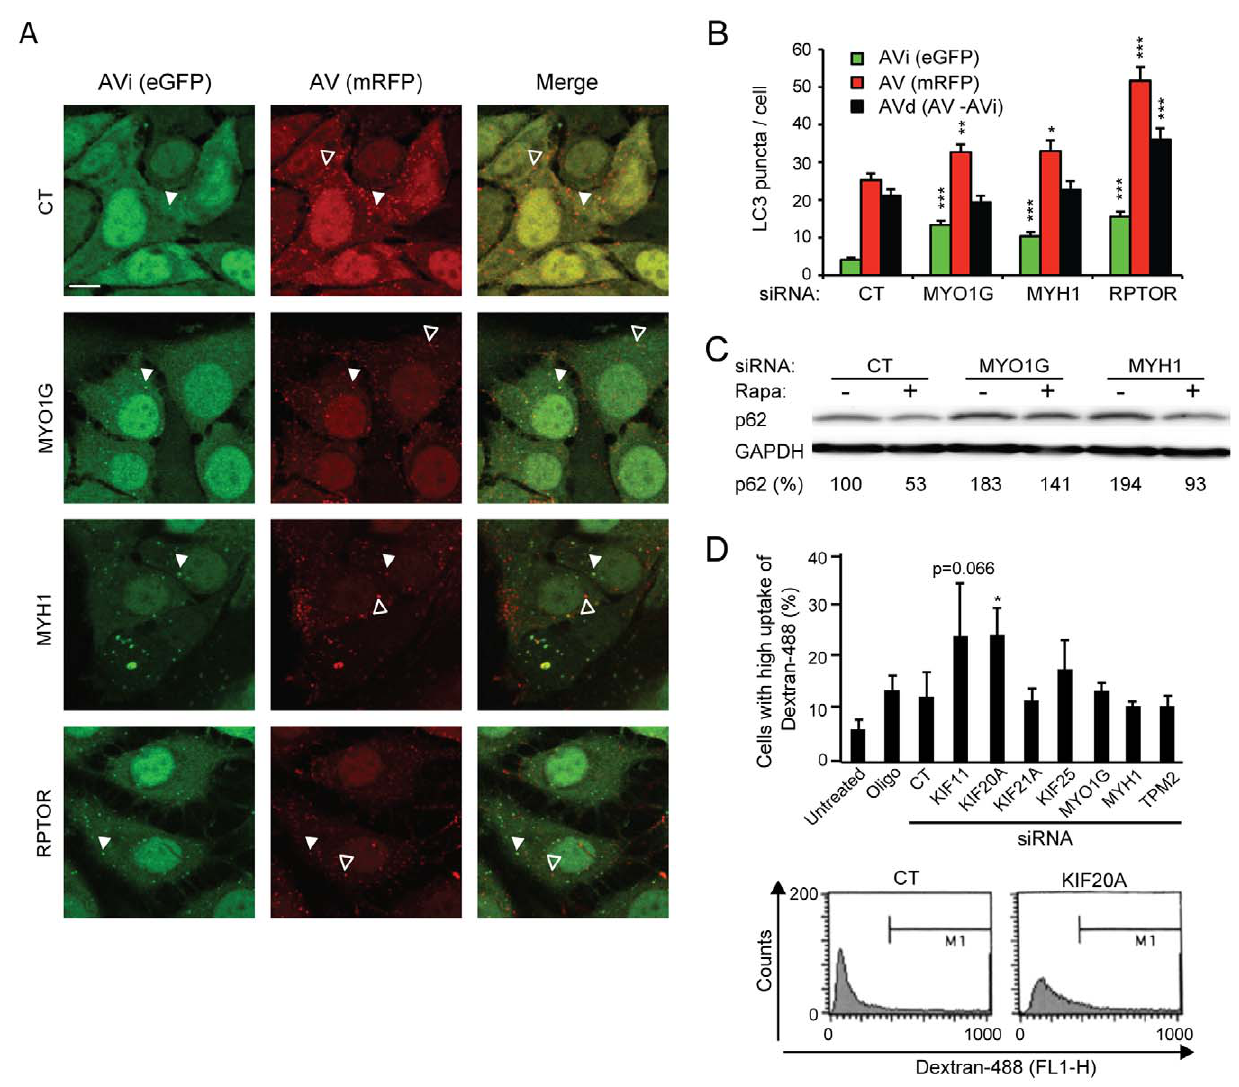
Figure 3. Effect of the identified siRNAs on autophagy and dextran uptake. (A–D) tfLC3-MCF7 cells (A, B) or MCF7 cells (C, D) were left untreated, treated with Oligofectamine (Oligo) or transfected with control siRNA (CT) or indicated siRNA pools (3 6 6.67 nM). (A, B) After 48 h, tfLC3- MCF7 cells were analyzed by confocal microscopy. Representative images (A; Bars , 10 m m) and quantification of puncta (B) are shown. Raptor siRNA (RPTOR) served as a control for increased autophagic flux. Closed arrows indicate AVd, open arrows indicate AVi. (C) After 60 h, the level of p62/ SQSTM1 (p62), which is degraded by autophagy, was examined by Western blot. Rapamycin (20 nM, 4 h) was used to induce autophagy. Numbers represent p62 levels as percentage of the level in untreated control siRNA-transfected cells. (D) Top , After 60 h, MCF7 cells were treated with 100 m g/ ml Alexa Fluor 488-dextran (dextran-488) for 1 h and analyzed by flow cytometry (FL1-H). The threshold for high intensity staining was defined so that 88% of control siRNA-transfected cells were below. Bottom , Example histograms showing dextran-488 content of cells transfected with control or KIF20A siRNA. M1=gate for high intensity staining. Values represent means + SEM of 20 cells in one representative experiment (B, n=3) or means + SD of three independent experiments (D). * P , 0.05, ** P , 0.01, *** P , 0.001, vs. control siRNA-transfected